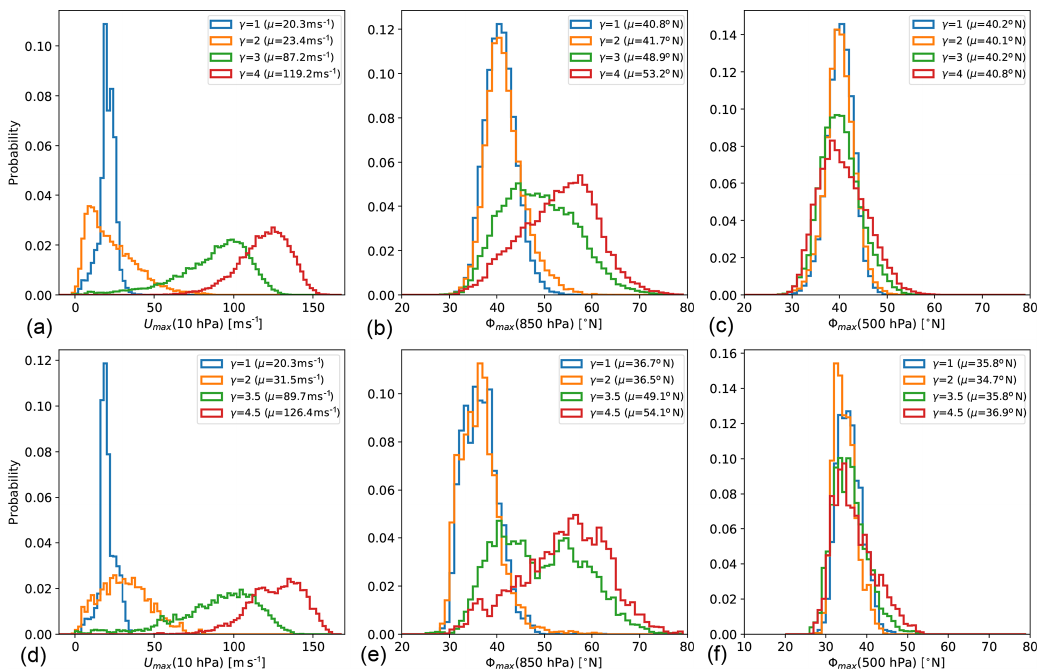
Figure C3. As Fig. C1 but for simulations with WN2 heating and p Tw = 400hPa for (a, b, c) the standard setup and (d, e, f) the modified setup with reduced δ z